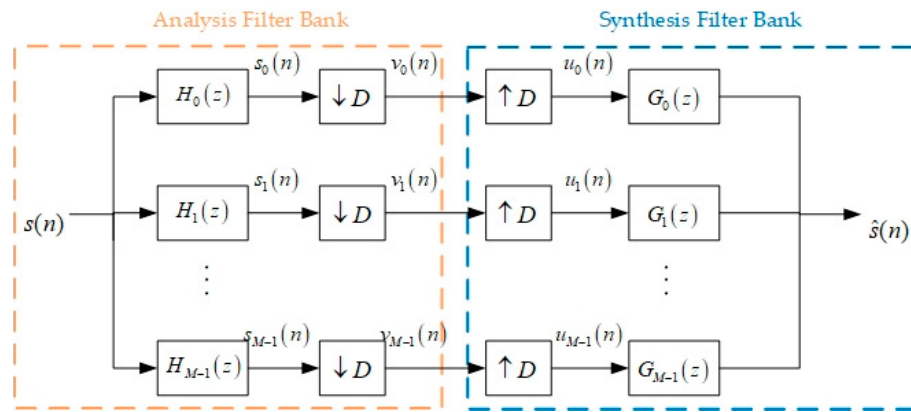
Figure 2. M-channel multi-rate filter bank.